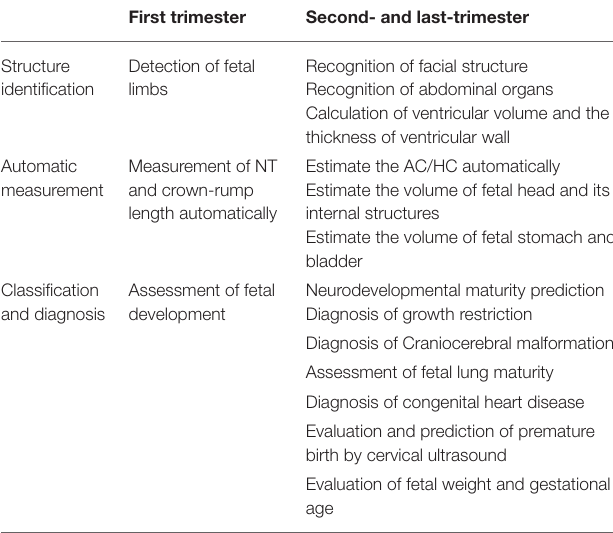
TABLE 1 | The application of AI in accuracy improvement of obstetric